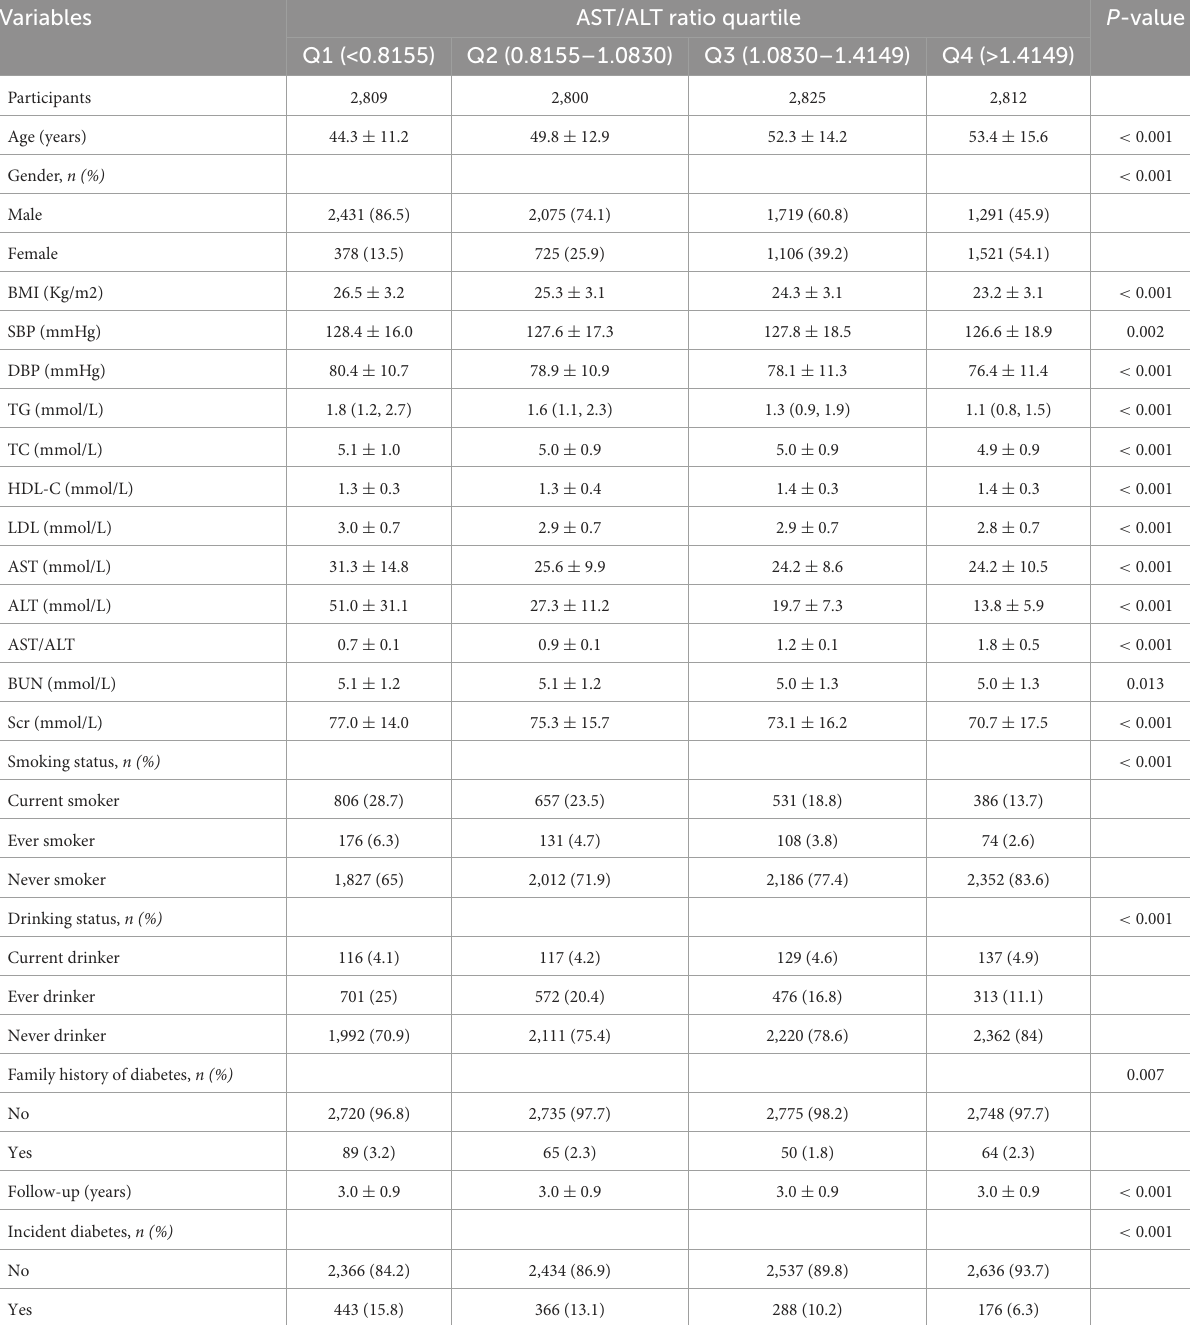
TABLE 1 Baseline characteristics of participants stratified by quartiles of AST/ALT ratio. Variables